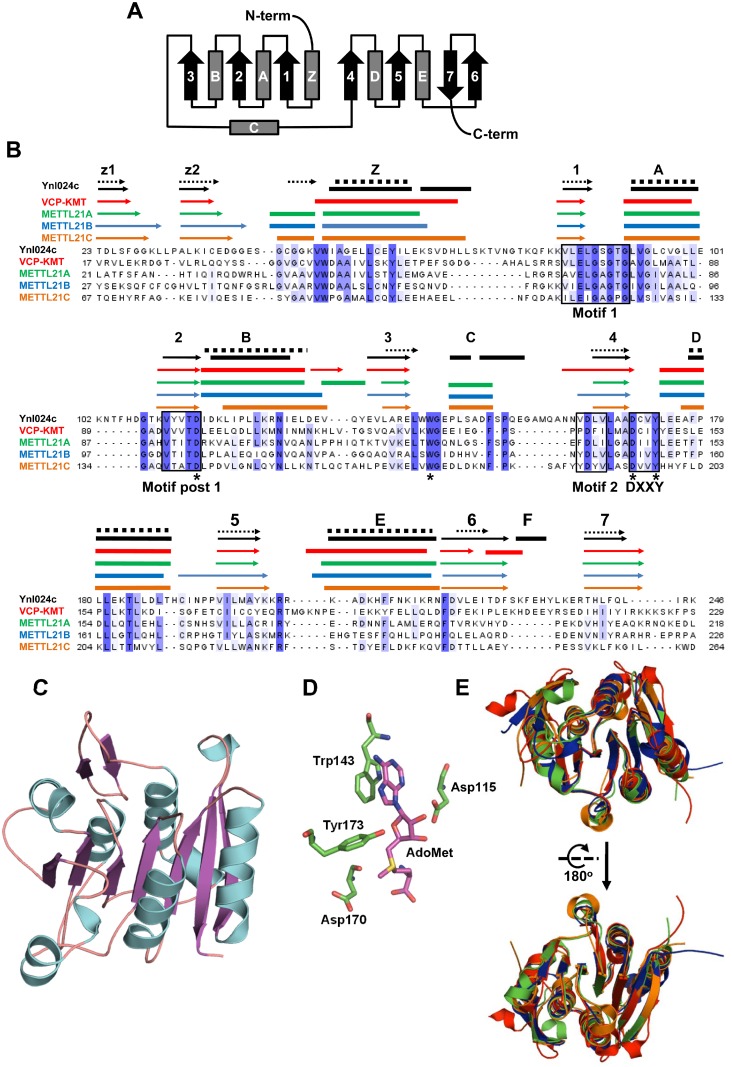
Sequence analysis and structural modelling of Ynl024c.(A) Topology diagram of the canonical 7BS MTase fold. Arrows and rectangles indicate β-strands and α-helices, respectively. The seven β-strands are designated “1–7”, the α-helices connecting them “A-F”, and the secondary structure elements preceding the 7BS-fold denoted “Z”. B, Protein sequence alignment of Ynl024c and human METTL21 proteins. Motifs “I”, “Post I” and “II”, which are shared by all 7BS MTases, as well as the DXXY motif, a hallmark of MTF16, are indicated by boxes. Above the alignment are indicated the secondary structure elements from the solved crystal structures of VCP-KMT (red; pdb 4LG1), METTL21A (green; pdb 4LEC), METTL21B (blue; pdb 4QPN) and METTL21C (orange; pdb 4MTL), a predicted Ynl024c structure (black; see also (C)), as well as a secondary structure prediction for Ynl024c, performed with Jpred 3 (dashed, black). β-strands and α-helices are indicated by arrows and thick lines, respectively, and the numbering/lettering of these are as outlined in A). Asterisks indicate conserved active site residues represented in (D). (C) Predicted structural model of Ynl024c. The model was generated by one-to-one threading with Phyre2, using METTL21A as a template. (D) localization of putatively important catalytic residues (green) in the active site of the Ynl024c structural model. AdoMet is shown in purple. The shown residues are indicated by asterisk in the sequence alignment in (B). (E) Structural alignment of human VCP-KMT, METTL21A, METTL21B and METTL21C (Color code as in (B)).